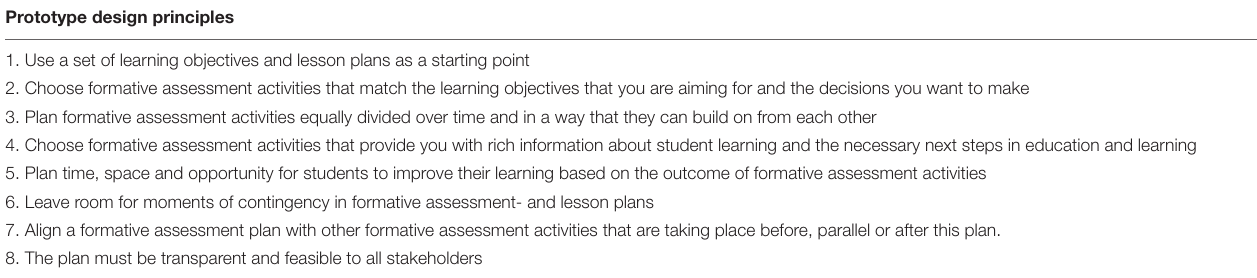
TABLE 7 | Prototype design principles formative assessment plans. Prototype design